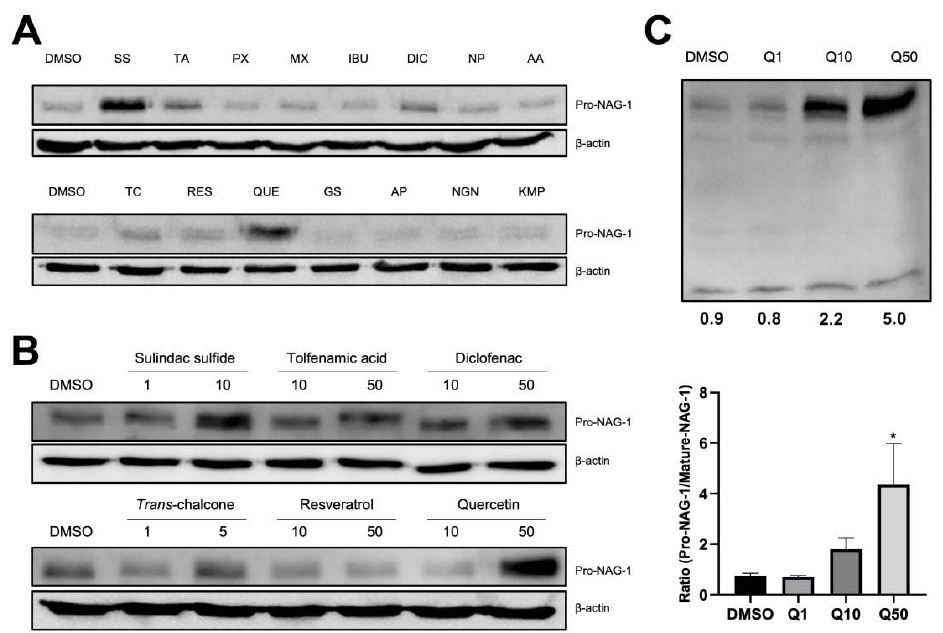
Figure 3. Pro-NAG-1/GDF15 expression in the presence of several anticancer compounds. ( A ) The human thyroid cancer cell line BCPAP was exposed to different nonsteroidal anti-inflammatory drugs (NSAIDs) and phytochemicals for 24 h with serum-free media (sulindac sulfide (SS): 10 µ M, trans -chalcone (TC): 5 µ M; tolfenamic acid (TA), piroxicam (PX), meloxicam (MX), ibuprofen (IBU), diclofenac (DIC), naproxen (NP), acetaminophen (AA), resveratrol (RES), quercetin (QUE), genistein (GS), apigenin (AP), naringenin (NGN), and kaempferol (KMP): 50 µ M). Cells were harvested, and the proteins were extracted with radioimmunoprecipitation assay (RIPA) buffer. Proteins were subjected to western blot to detect pro-NAG-1 and β -actin expression. ( B ) BCPAP cells were exposed to different doses (sulindac sulfide; 1, 10 µ M, trans -chalcone: 1, 5 µ M; others: 10, 50 µ M) of anticancer compounds for 24 h with serum-free media. Western blot analysis was conducted as described in the Methods section. ( C ) Quercetin at doses of 1, 10, and 50 µ M were treated to BCPAP cells. Pro- and mature NAG-1 were detected by western blot. The bottom number represents the ratio of pro- and mature NAG-1 expression, three independent experiments and a statistical analysis were done. * p < 0.05. Uncropped versions of blots presented in the Figures S6 and Figure S7.